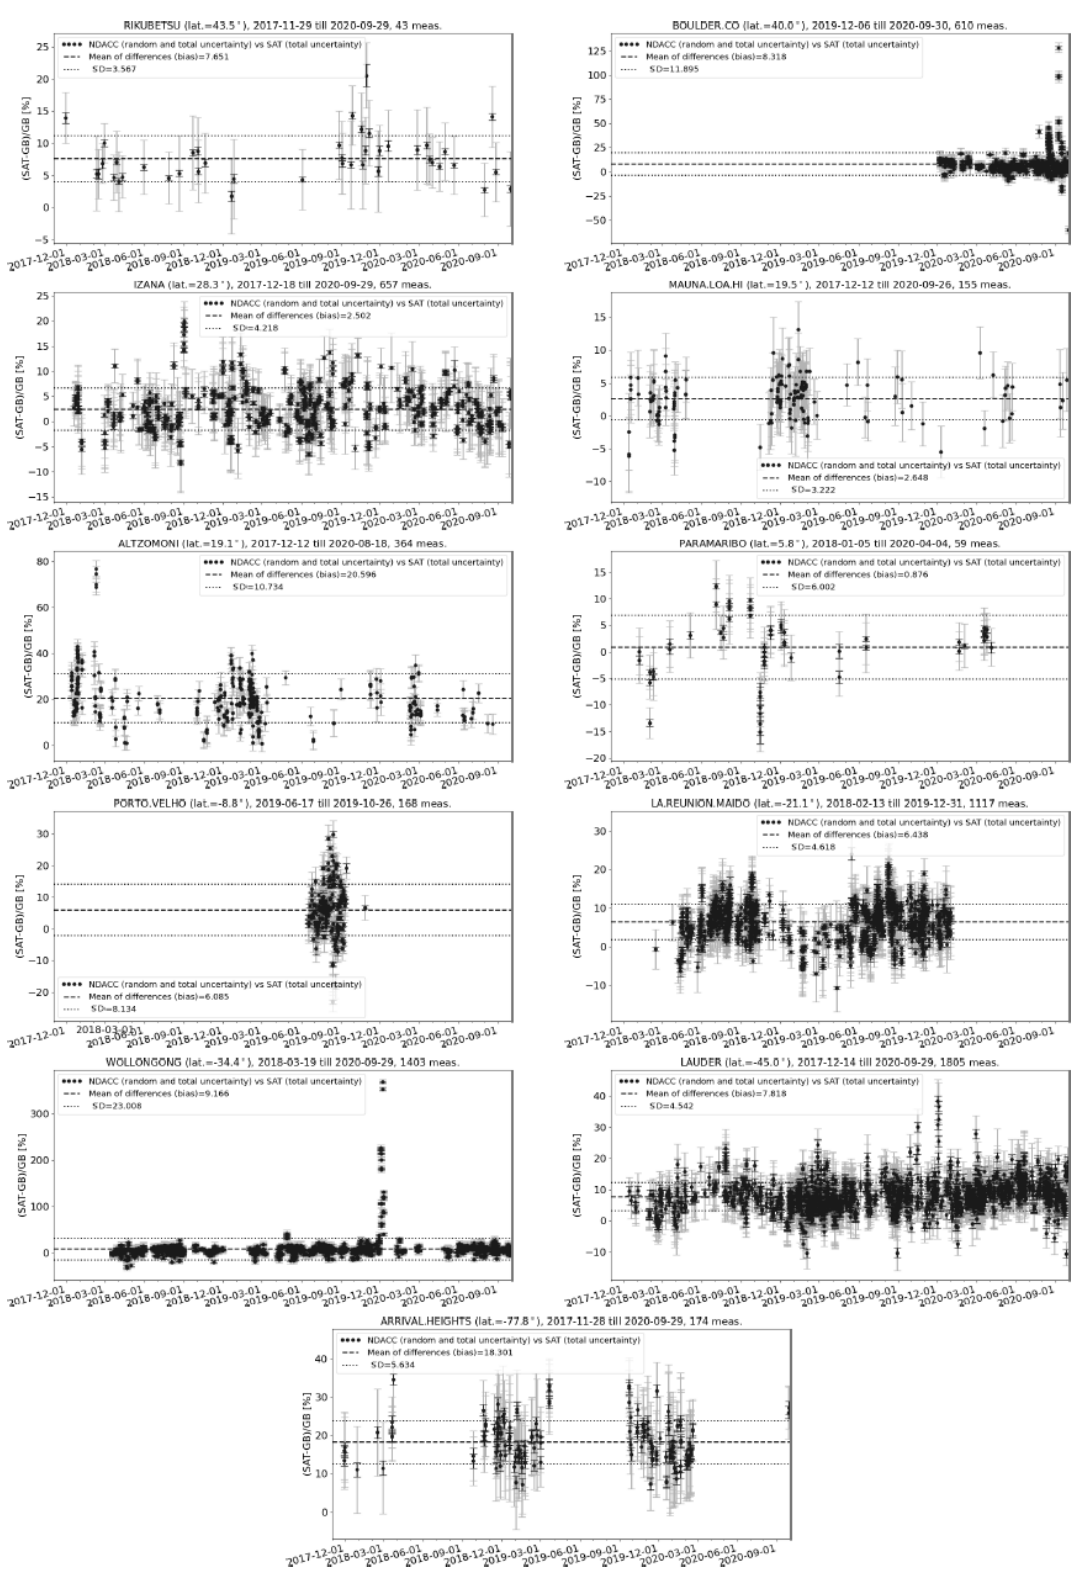
Figure 30. Same as Fig.